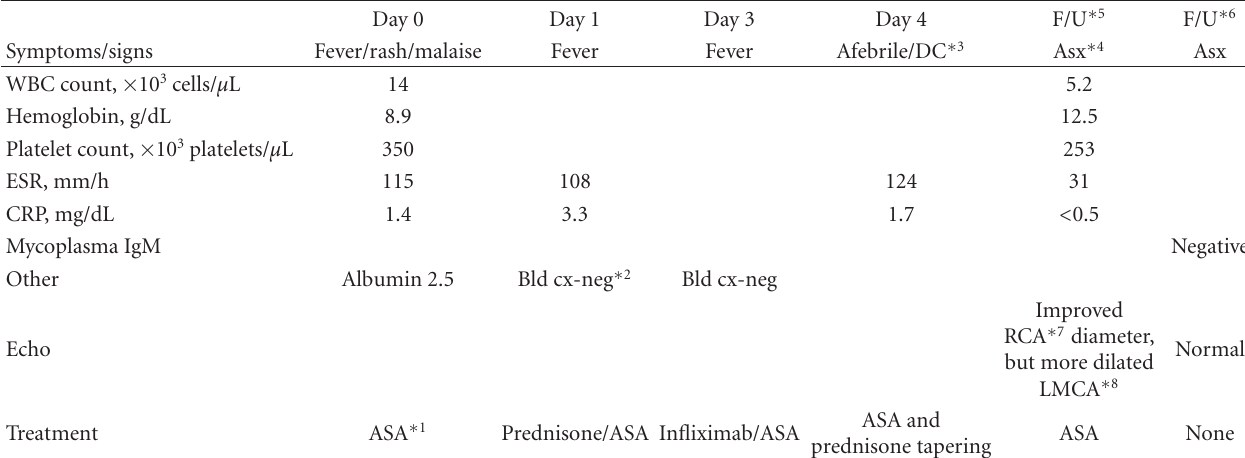
Table 2: Second admission inpatient hospital course.